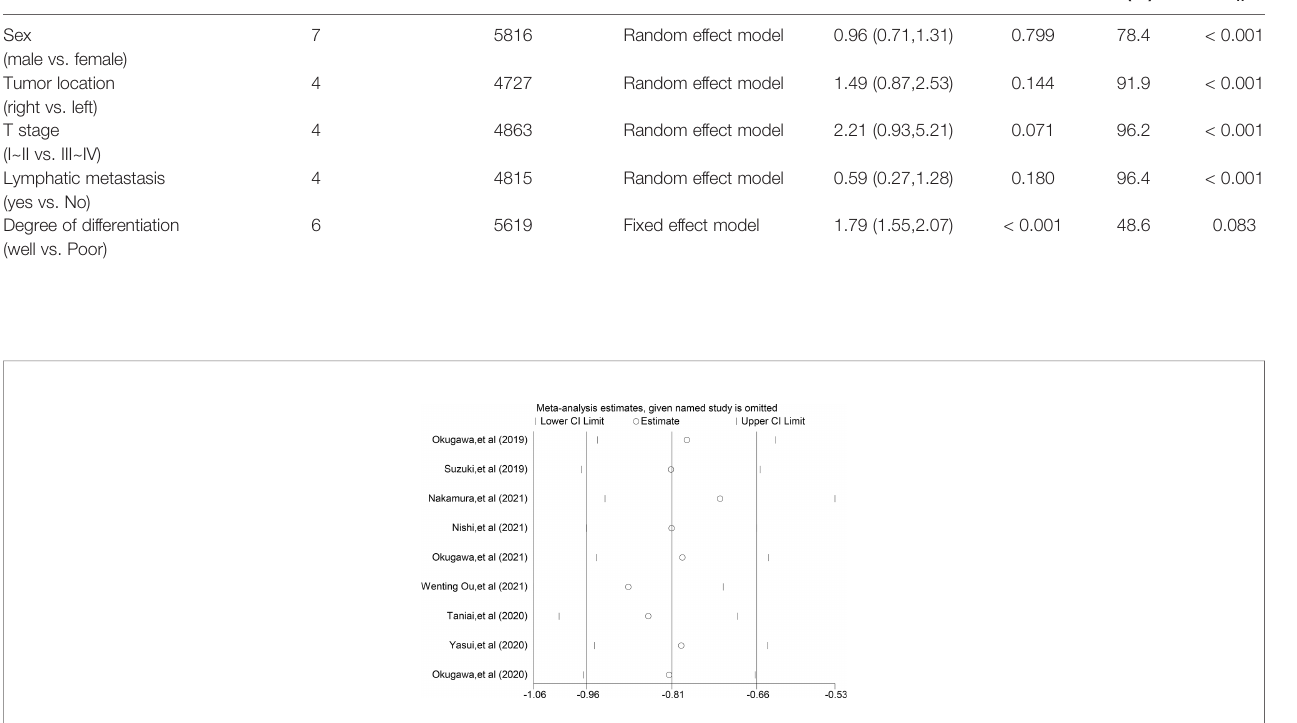
FIGURE 4 | Sensitivity analysis of relationship between LCR and OS.